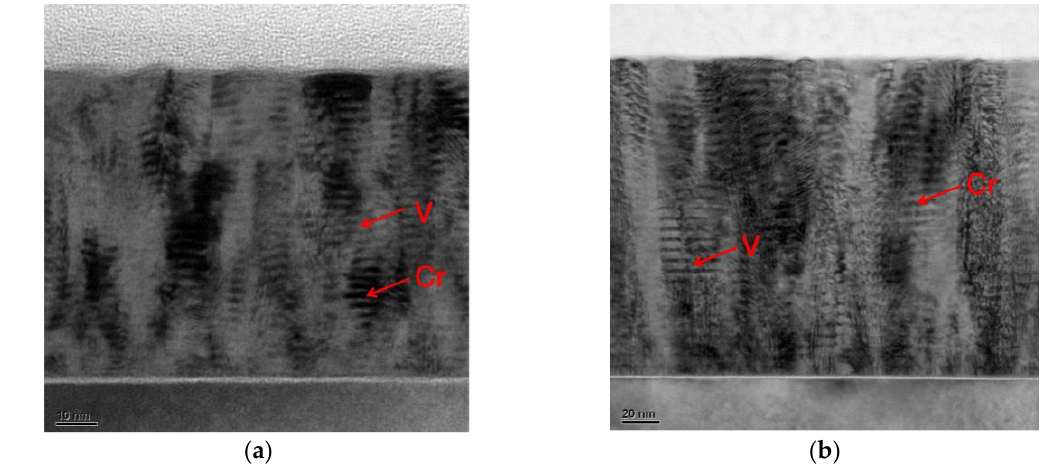
Figure 5. Bright field TEM images of Cr/V multilayer samples with vanadium layers thickness ( a ) d V =1.2 nm and ( b ) d V =4.0 nm.